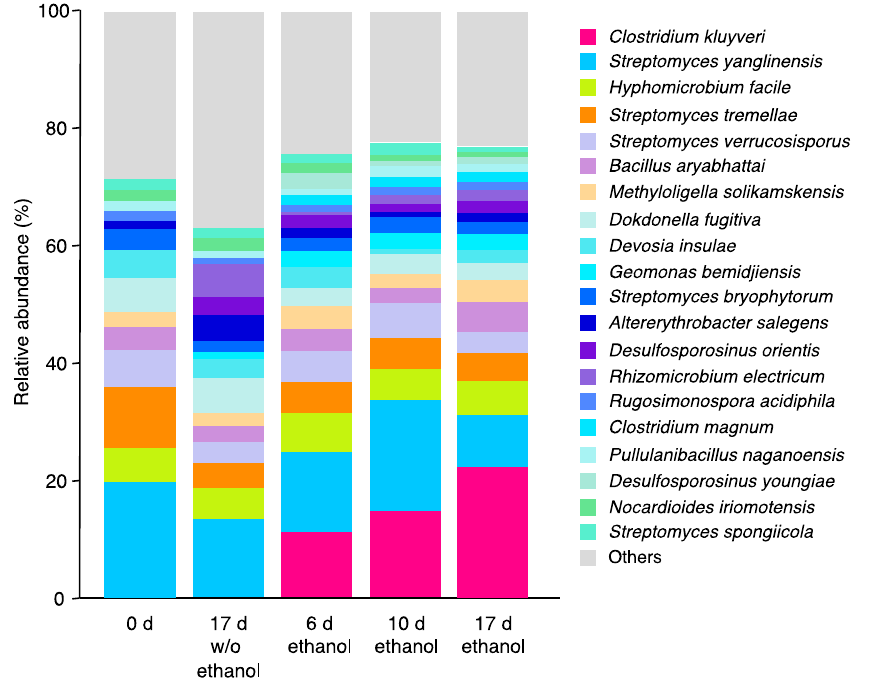
Figure 2. Species-level bacterial community structures before (0 d) and after (17 d) the laboratory- scale ASD performed at 30 °C as determined by high-throughput sequencing of 16S rRNA genes. Bacterial community shifts during ASD (6 d and 10 d) are also shown .